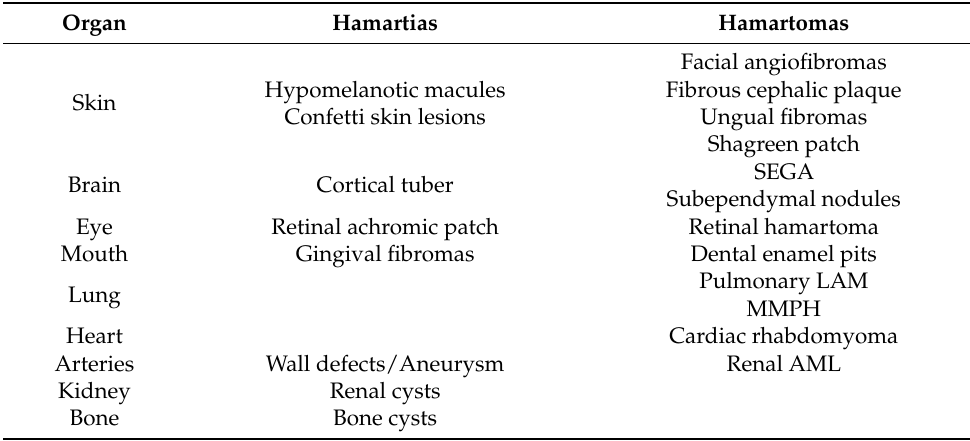
Table 1. Characteristic lesions of TSC (modified from Gomez (1999) [29]).